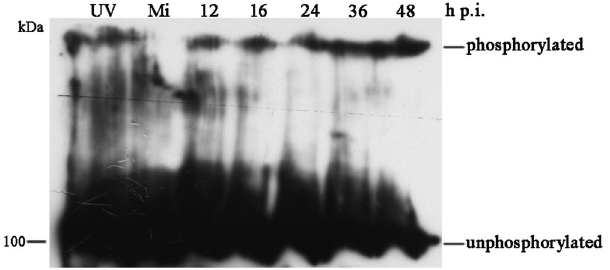
Figure 5. Phosphorylation of GFP-lamin B during baculovirus infection. Sf9-L cells were mock-infected or infected with vAcWT. The cells were harvested at the indicated time points p.i. The proteins were separated by Mn 2 + -Phos-tag SDS-8% PAGE and subjected to Western blotting with a mouse monoclonal anti-GFP antibody. Sf9-L cells exposed to ultraviolet light (UV) for 4 h were used as a positive control. Mi, mock-infected Sf9-L